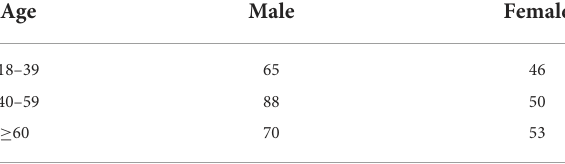
TABLE 2 General demographic information. TABLE 3 Results of MEWS score in patients with different outcomes ( ¯ X ± s,